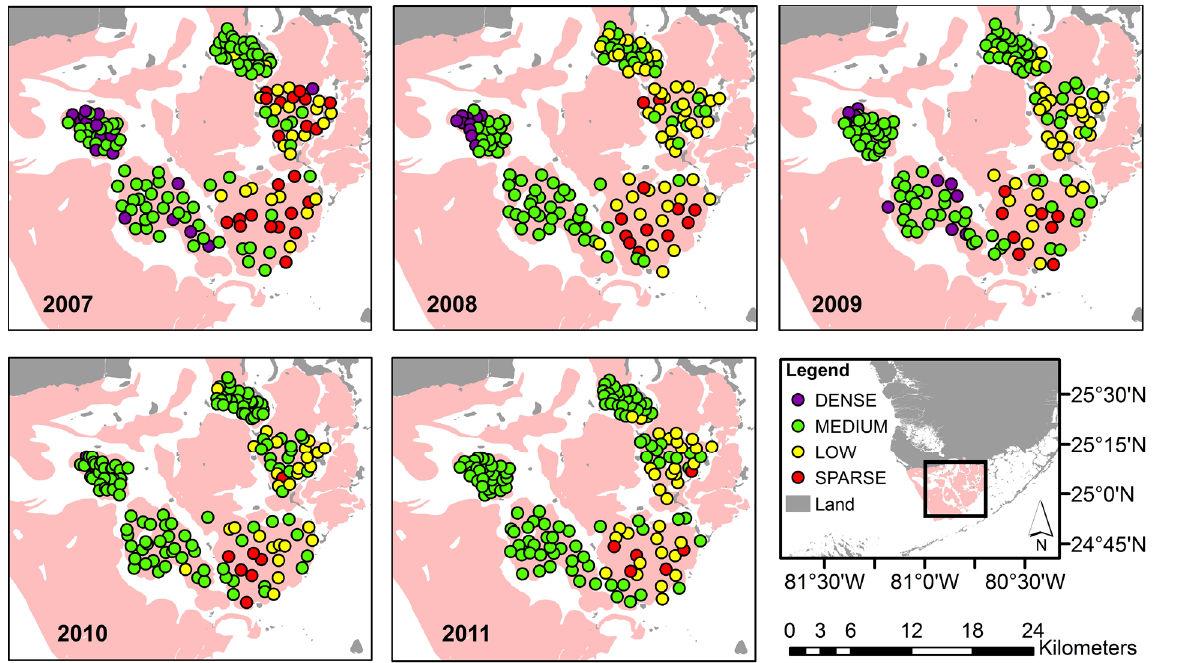
Figure 3. Map summary of in-situ data showing the distribution of cover classes across survey